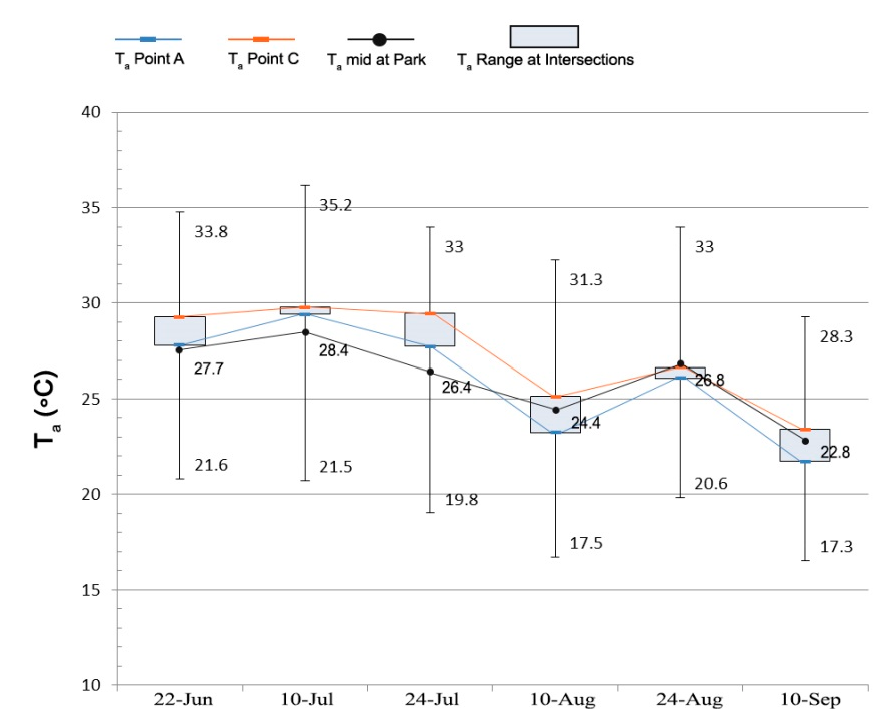
Figure 6. The diagram shows the temperature range of the three intersections A, B and C measured and the temperature range of Rétiro Park during the six days of hot summer 2018 in Madrid . Gray rectangles: Temperature range at three intersections (bottom side: T a A, top Side: T a C). Linear range: The temperature range of the park is based on AEMET (bottom line: T a mid of park, top line: T a Max of the park. Table 6. Mean values for air temperature (T a ), in the three intersection (10:40–12:10 CET) and values for air temperature (T a ), relative humidity (RH) and wind velocity (W) in the Retiro Park on all the measurement days.